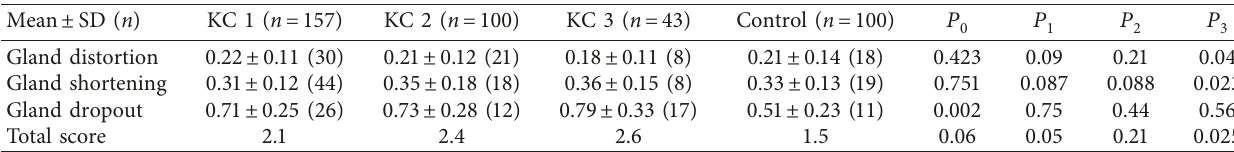
Figure 1: (a) Normal meibomian glands with no distortion nor dropout. (b) Grade 1 with dilatation and tortuosity of the MG. (c) Grade 2: dropout of MG along with gland distortion. (d) Grade 3: MG does not traverse the total tarsal with mottling of details. Table 3: Meibomian gland characteristics in all groups.